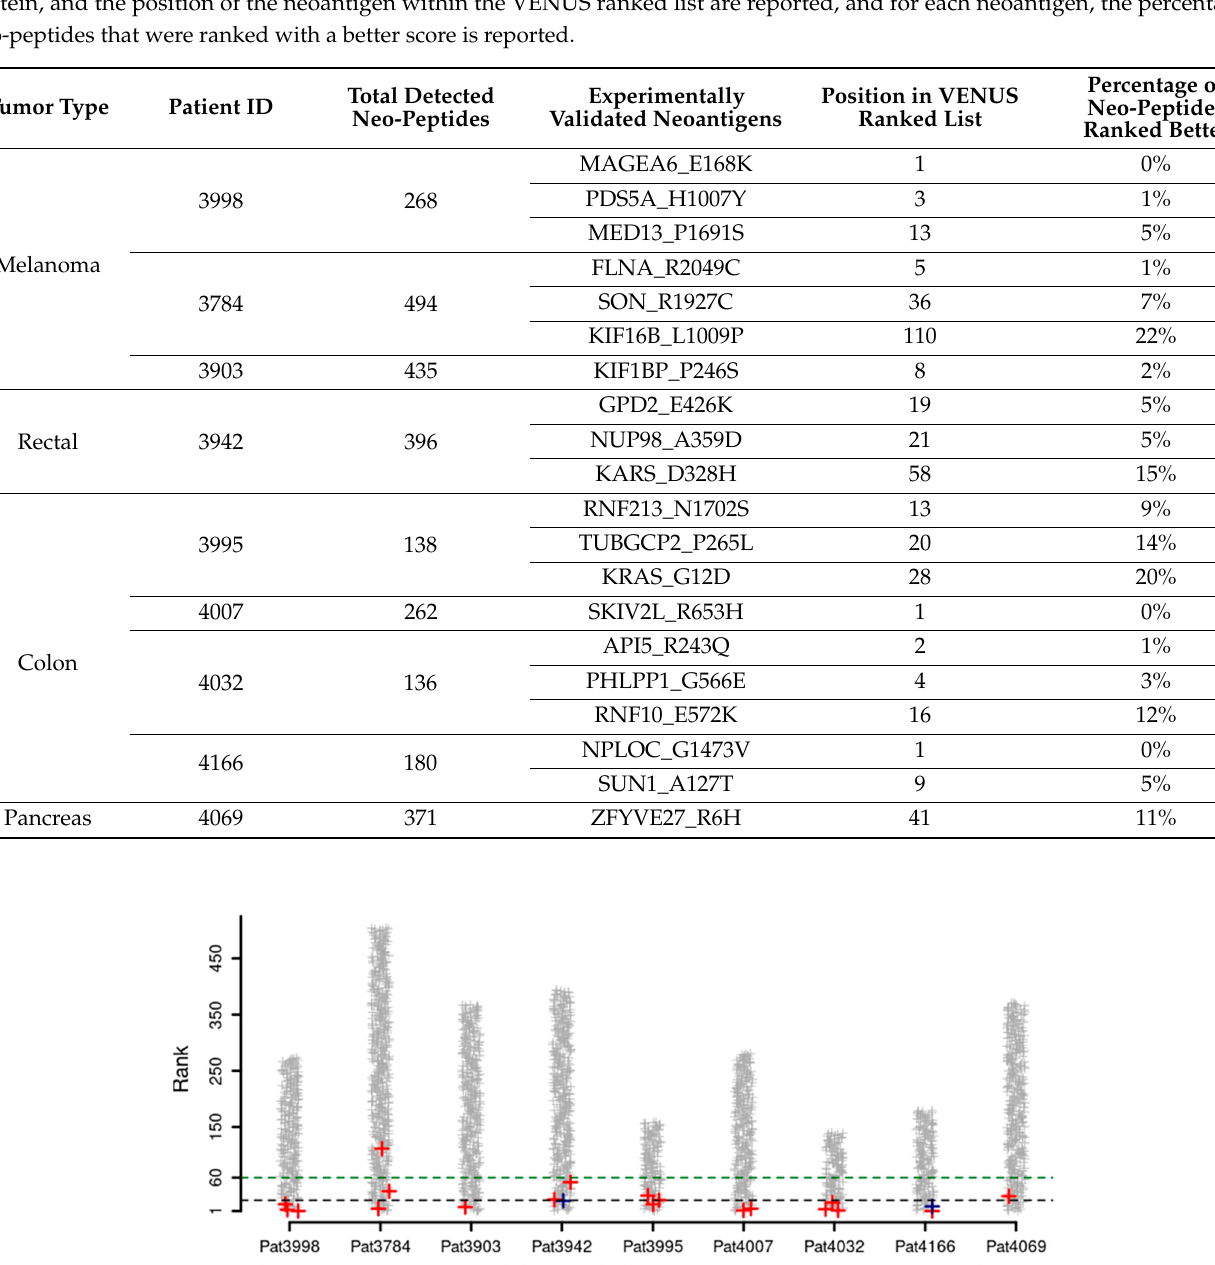
Table 1. Position of experimentally validated neoantigens in patient-specific lists of ranked according to VENUS score. For each patient, the total number of mutation-derived neo-peptides, the position of the neoantigens with validated T-cell reactivities in the protein, and the position of the neoantigen within the VENUS ranked list are reported, and for each neoantigen, the percentage of neo-peptides that were ranked with a better score is reported.